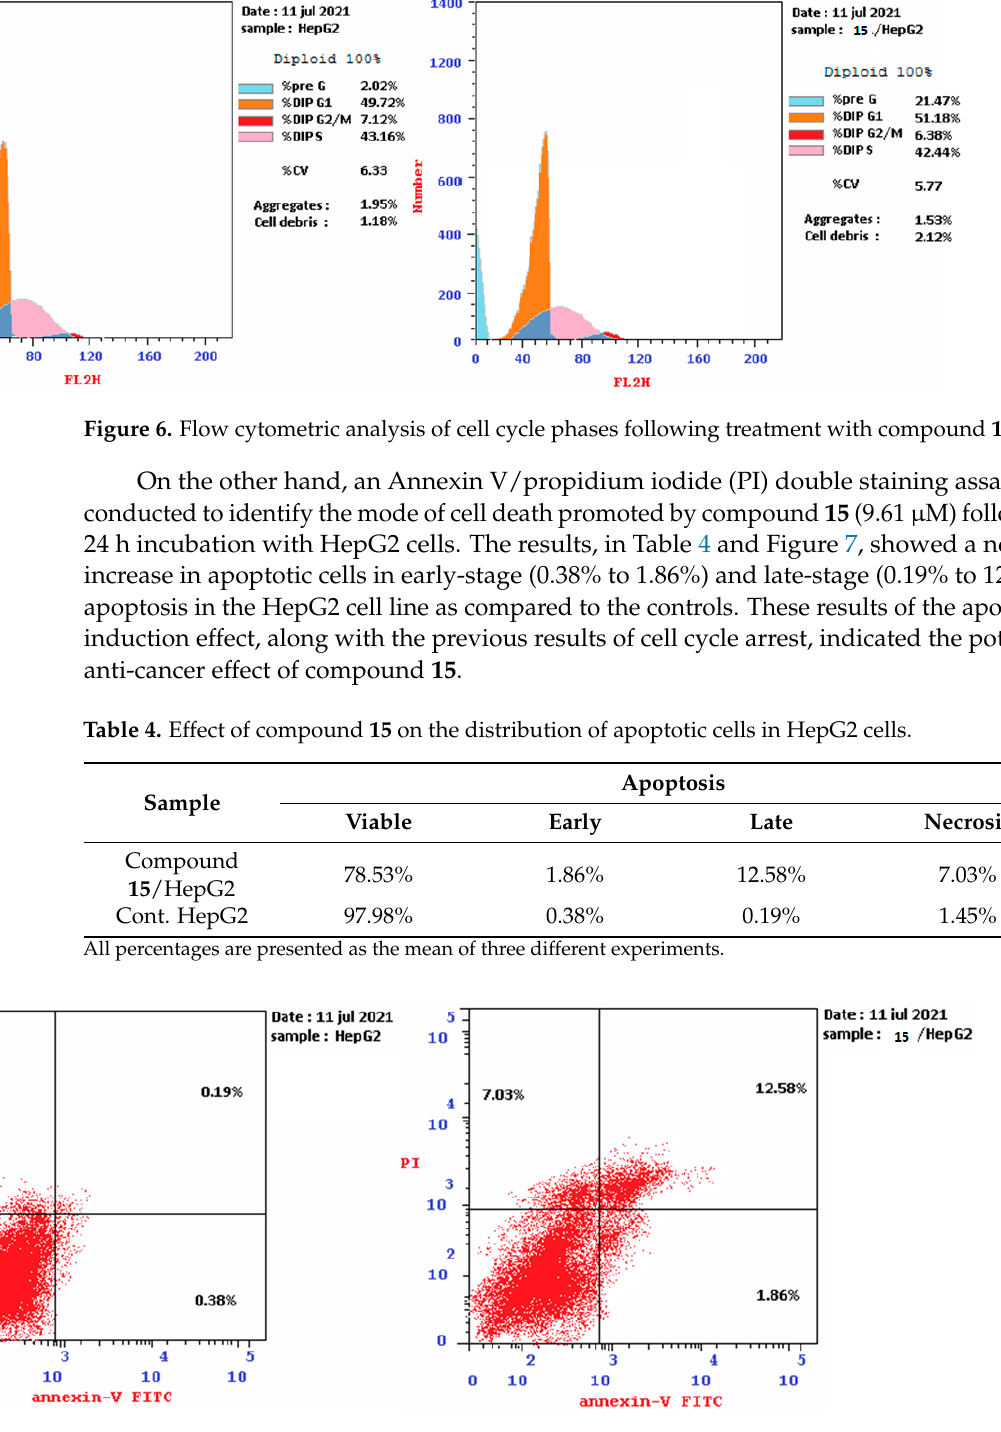
Figure 7. Flow cytometric analysis of apoptosis in HepG2 cells following treatment with compound 15